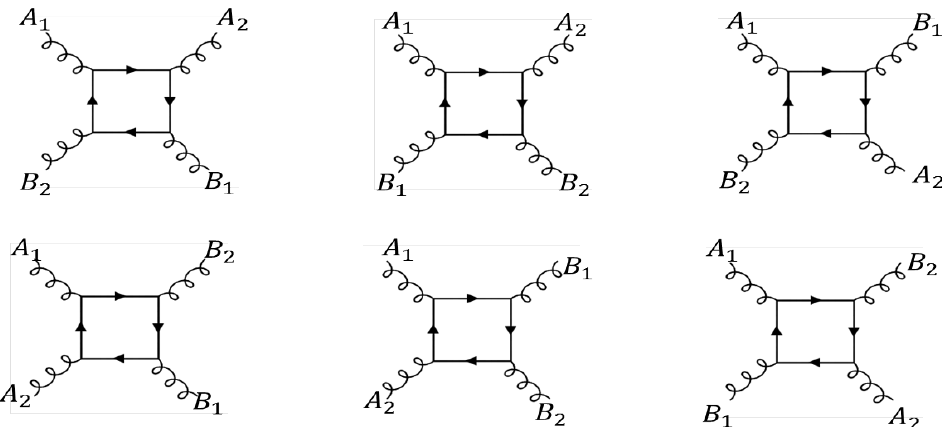
( p i ) and (cid:22) i